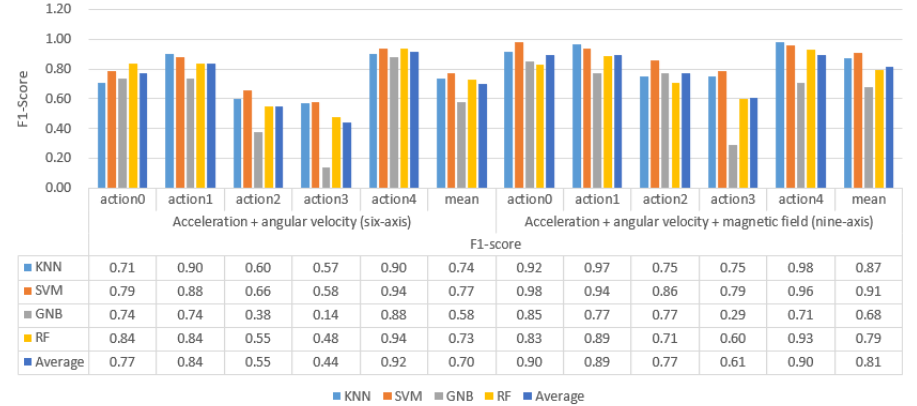
Figure 10. The recognition accuracy of traditional machine learning models based on artificial features on professional test sets.